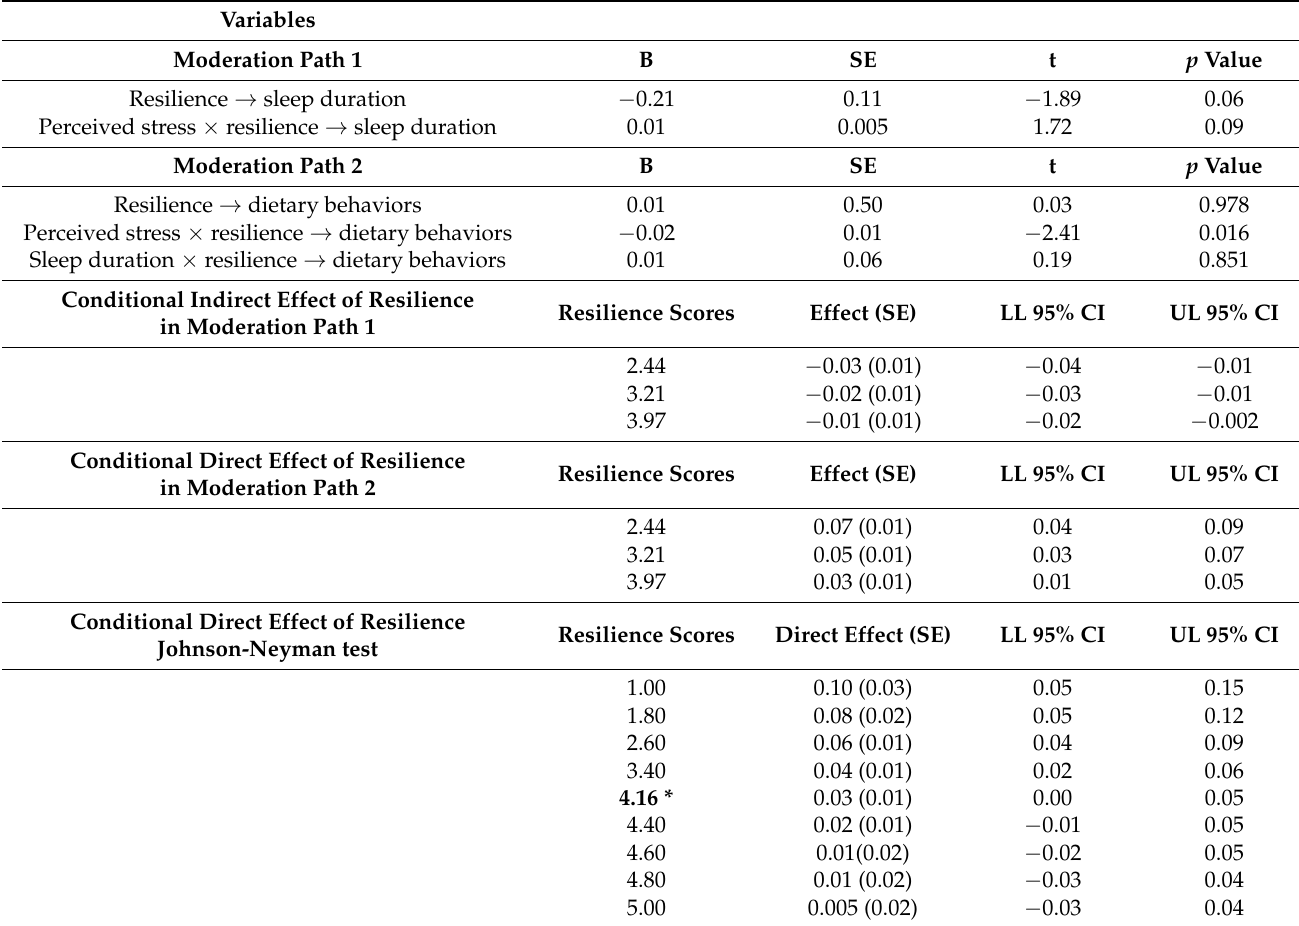
Table 9. Model 2 moderation